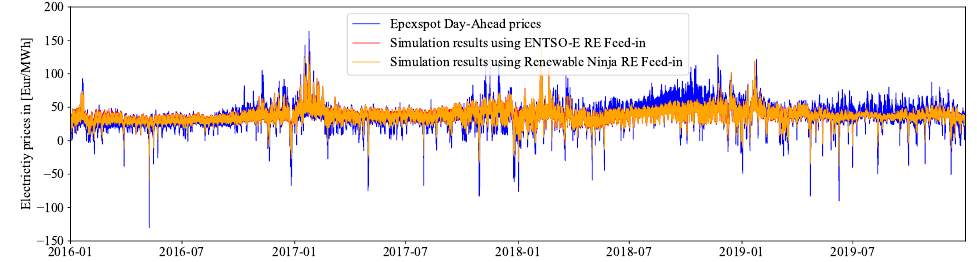
Figure 6. Comparison of day-ahead EPEX SPOT prices and model results for the years 2016–2019 using both ENTSO-E and renewable.ninja data.